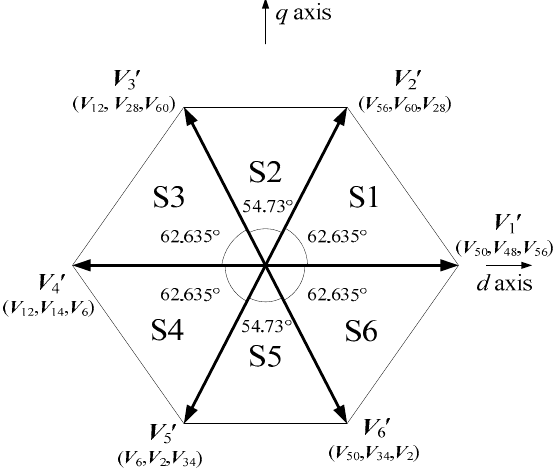
Figure 8. Six auxiliary vectors, six sectors, and a nonregular hexagon in the d - q plane.